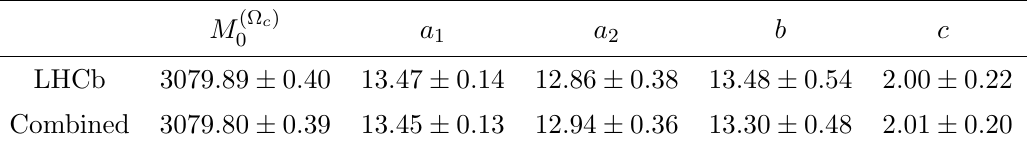
Table 16 . The (cid:31) 2 -analysis of the orbitally-excited (cid:10) (cid:3) -baryon masses based on the measurements c by the LHCb and Belle collaborations. This analysis is performed based on the LHCb data alone and on the combined data set from both the LHCb and Belle collaborations presented in table